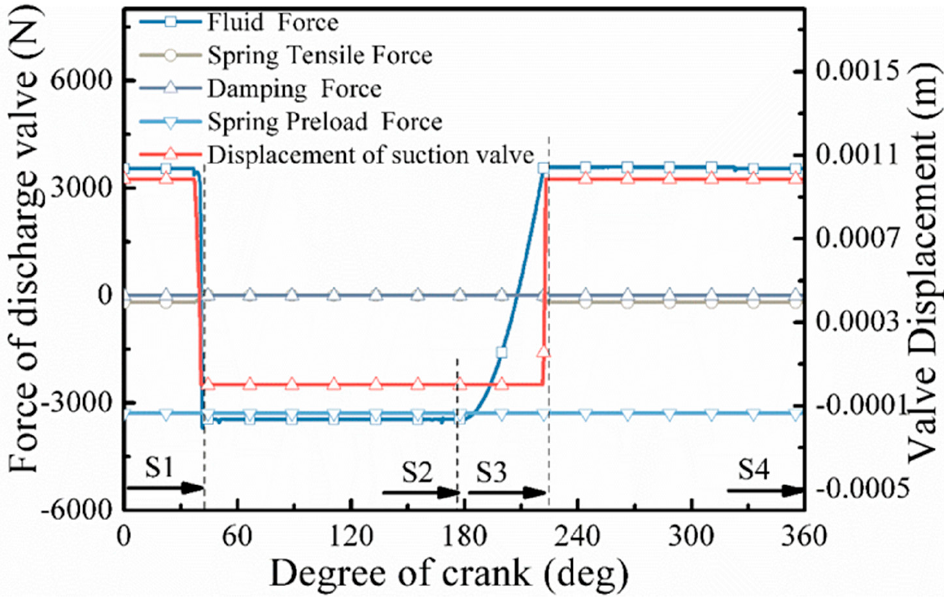
Figure 11. Coupling of force, displacement, and crank angle of the discharge valve.